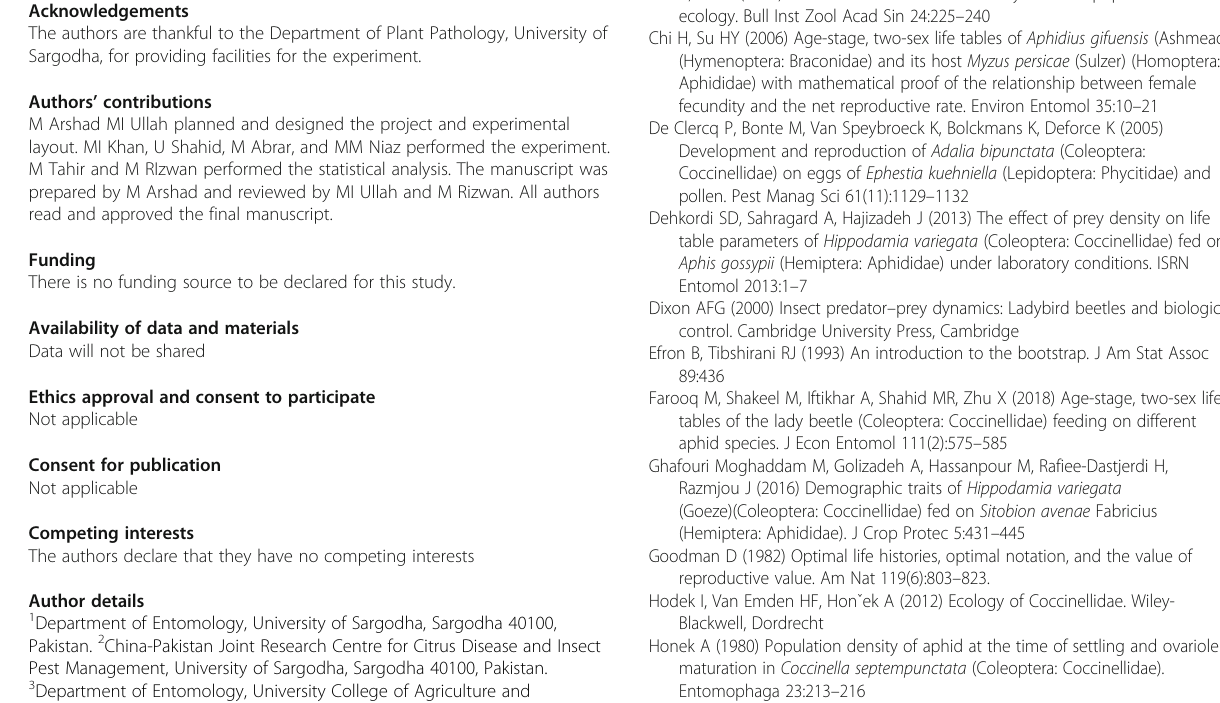
table analysis. http://140.120.197.173/ecology/. Chi H (2018) TWOSEX-MSChart: a computer program for the age-stage, two-sex life table analysis. National Chung Hsing University, Taichung, Taiwan, (http://140.120.197.173/Ecology/Download/Twosex-MSChart.zip) (accessed 23